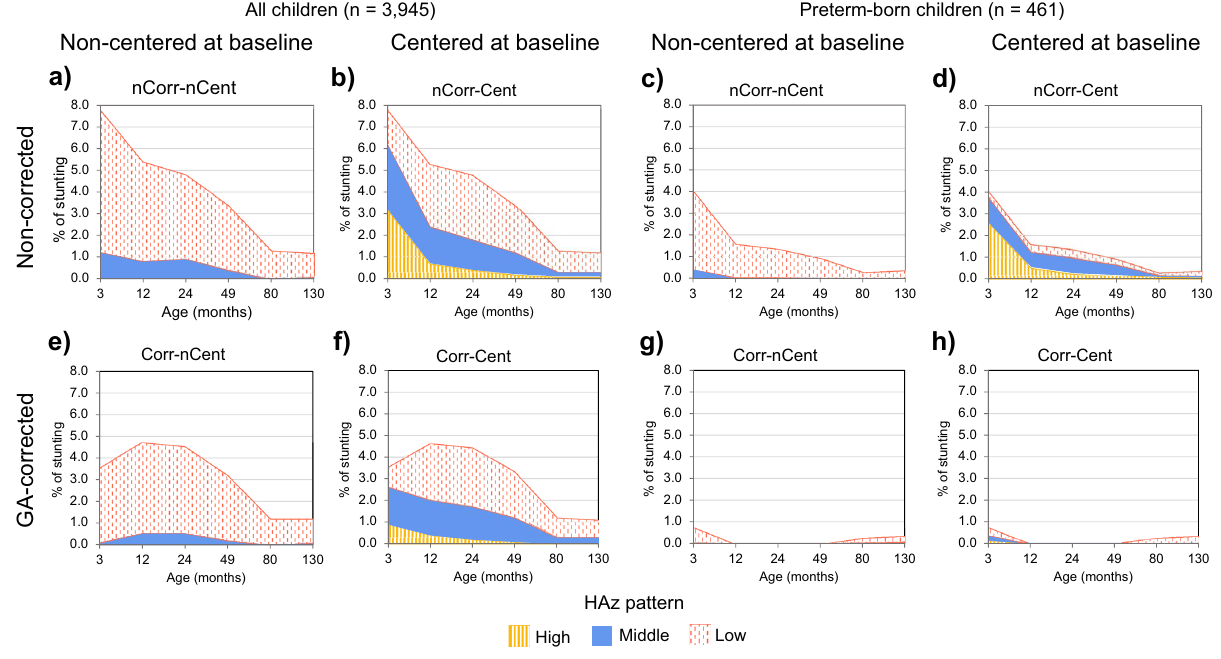
Figure 3. Percentage of children classified as stunted in each follow-up for all children and preterm-born in all approaches GA-corrected centered and non-centered clustering approaches. ( a , c ) Non-corrected, non-centered; ( b , d ) Non-corrected, centered; ( e , g ) GA-corrected, non-centered; ( f , h ) GA-corrected, centered. HAZ, height- for-age z-score; GA, gestational